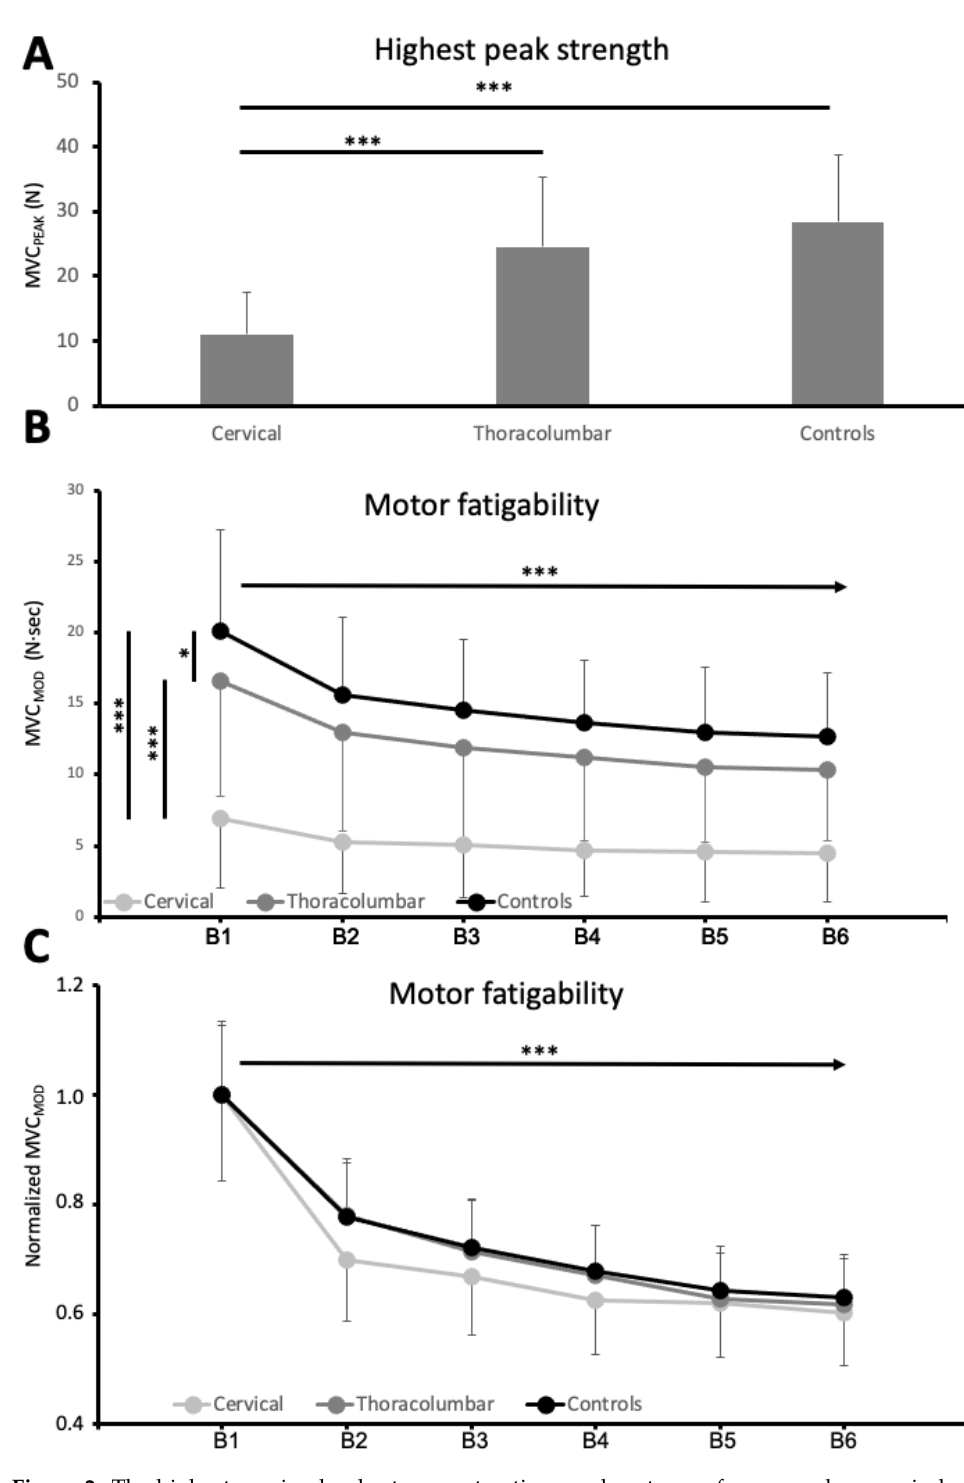
Figure 2. The highest maximal voluntary contractions and motor performance decrease induced by the isometric task. ( A ). The highest scores of force performed during the 120 s of isometric task (MVC PEAK ) for each group (cervical, thoracolumnar and controls) measured in Newton (N). ( B ). Reduction of muscle force along the 120 s task for each group (cervical, thoracolumnar and controls) measured in Newton · seconds (N · s). The unit in the y-axis represents to the modulus of maximal voluntary contractions MVC MOD , and x-axis represents 120 s task in 6 sequential 20 s periods (B1, B2, B3, B4, B5 and B6). ( C ). Normalized Figure 2B respect to the maximal MVC MOD for each group. Asterisks denote statistical significance *** p value < 0.001; * p <